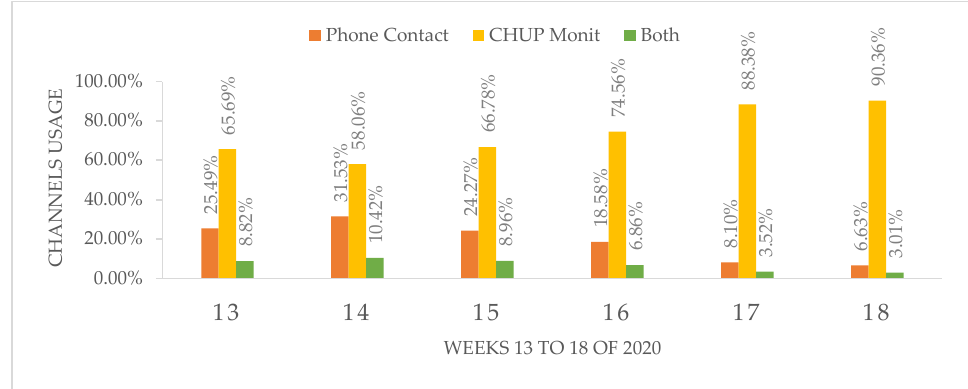
Figure 12. Channel utilization complementarity.